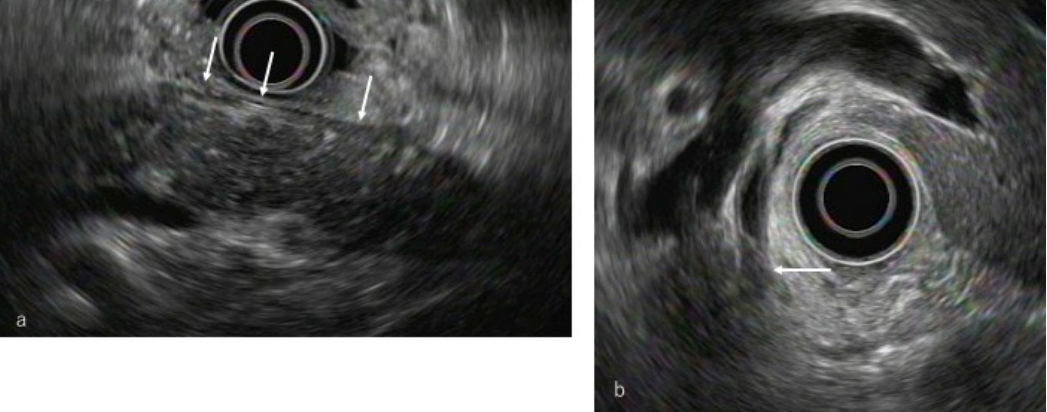
Figure 2. Endoscopic ultrasonography (EUS). ( a ) Conventional EUS findings showed diffuse pancreatic enlargement with a heterogeneous hypoechoic pattern (arrow). ( b ) EUS revealed wall thickening in the distal bile duct (arrow).